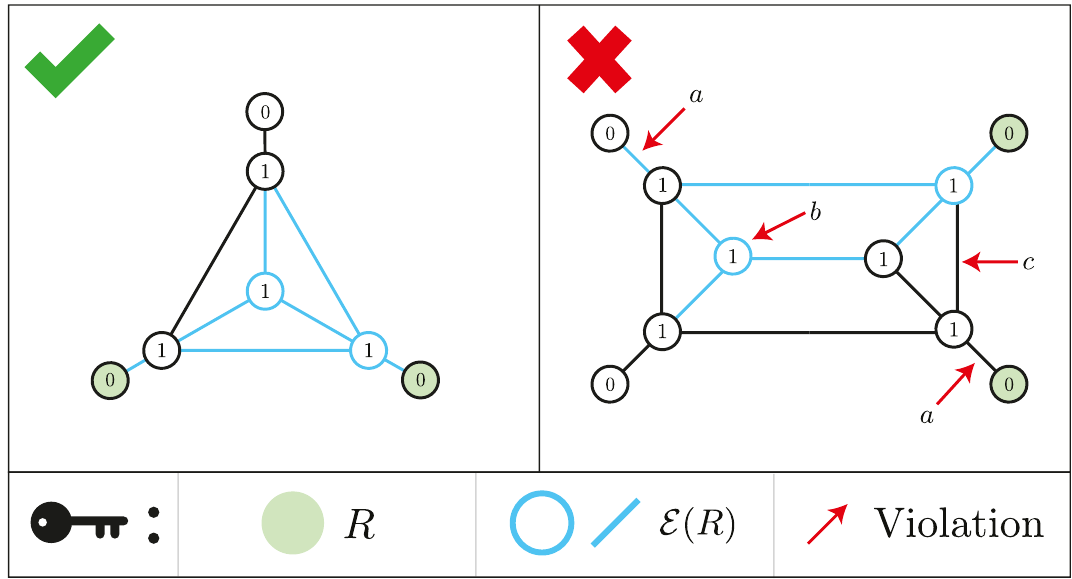
Figure 4. (Left) An example of a map E which, for the R shown, has a E ( R ) which is allowed for a near-boundary probing map. (Right) an example of an E ( R ) which is prohibited for a near- boundary probing map because of the following issues: a) There are elements of E ( R ) not 0 ∩ E connected to vertices in R and elements of E connected to edges in R that are not in E ( R ) , both 0 of which violate property 1 of the definition. b) there are vertices in E ( R ) not connected to an element of R by a path in E ( R ) ∪ R , and c) there are non-dangling edges e / ∈ E ( R ) that are incident on vertices in E ( R ) which are themselves not in E ( R )